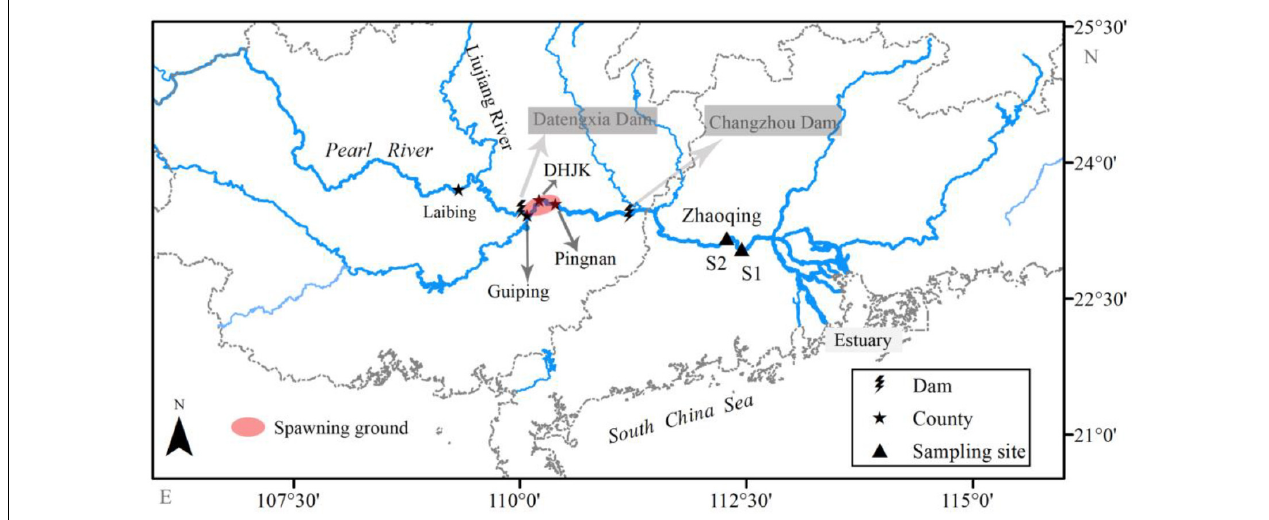
FIGURE 1 | Locations of dams near the spawning ground, sampling sites, and spawning ground of the collected larvae in the Pearl River (China). Sampling of larvae was conducted during 2006–2013 and 2017–2019. The daily temperatures and discharges of the spawning ground were collected from the DHJK gauge station from 2006 to